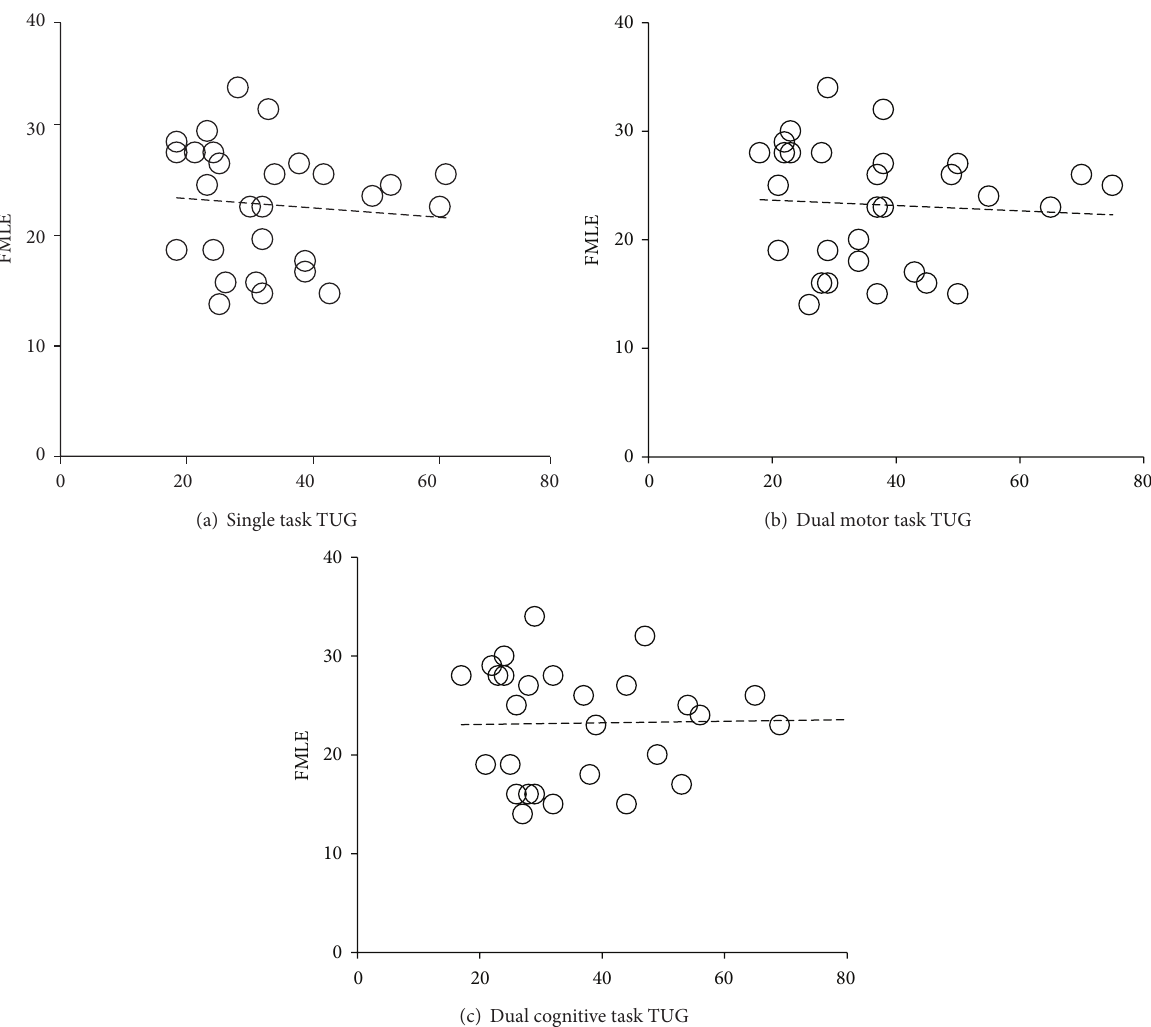
Figure 6: Scatter plots between Fugl-Meyer lower extremity motor (FMLE) scores and number of steps to complete Timed Up and Go (TUG) test across three attentional loading conditions. (a) Single task TUG, (b) dual motor task TUG, and (c) dual cognitive task